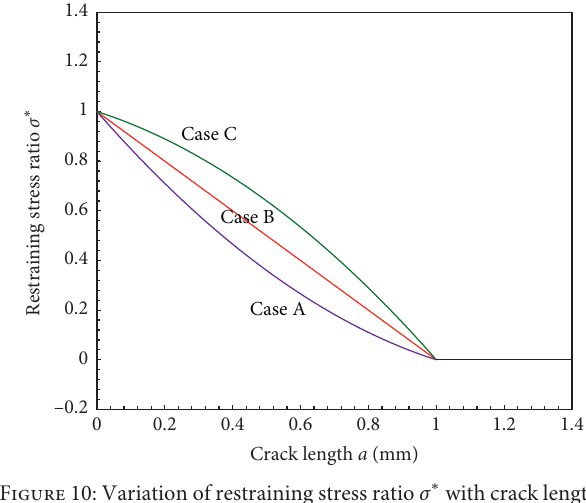
Figure 10: Variation of restraining stress ratio σ ∗ with crack length a